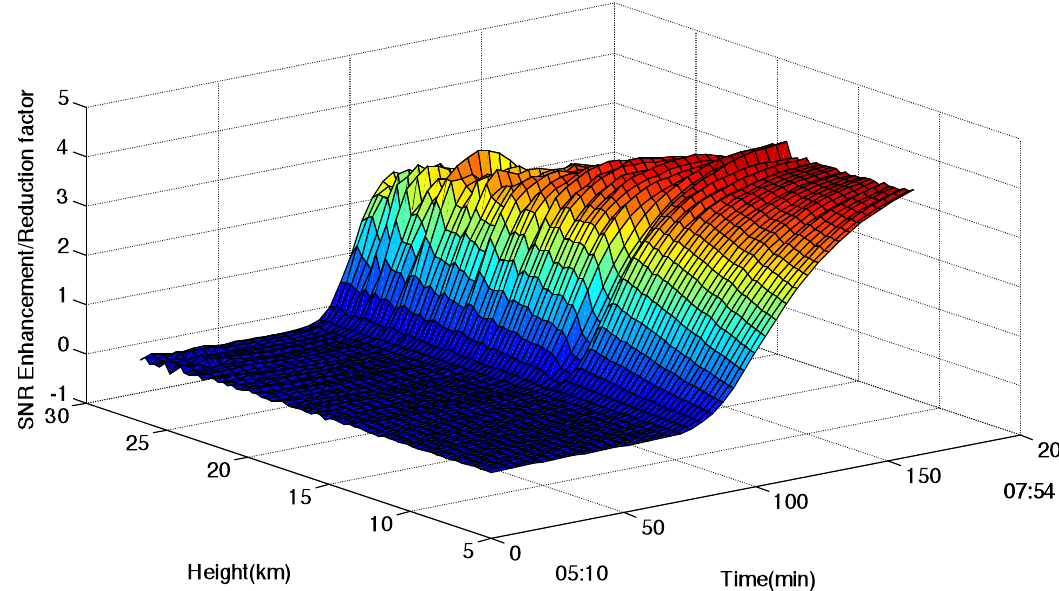
Figure 6. Plot showing the SNR enhancement/reduction factor for heights up to 25 km on March 4, 2010, from 0510 to 0754 LT. The times of the observations are given at the extreme ends of the plots, in local time. A near constant factor is seen for the full height coverage for the entire duration of the